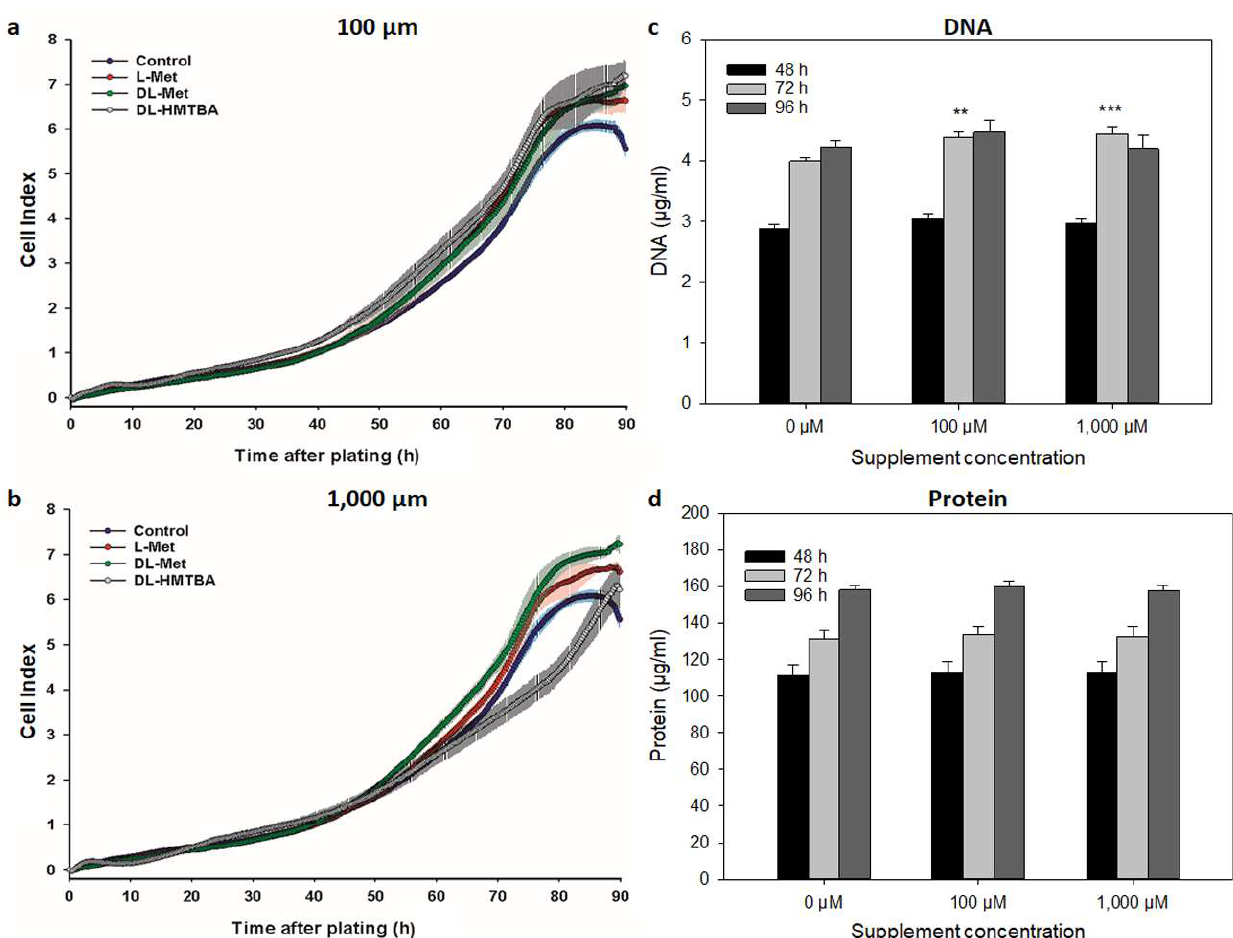
Figure 4. Effects of L-Met, DL-Met, and DL-HMTBA on growth kinetics ( a , b ) and DNA ( c ) and protein concentrations ( d ) of QM7 cells. Representative kinetic growth curves for QM7 cells (10,000 cells/well) supplemented with 100 µ M ( a ) or 1000 µ M ( b ) of L Met, DL-Met, or DL-HMTBA are shown in comparison with controls without supplement. For the evaluation of DNA ( c ) and protein ( d ) values, data for all methionine supplements were pooled since there were no statistical differences between them. Supplementation with methionine sources stimulated cell growth at both tested concentrations. DNA concentration in QM7 cells was significantly increased after methionine supplementation for 72 h. ** p ≤ 0.01 and *** p ≤ 0.001 vs. control; N = 3 (for growth curves) and N = 15 (for DNA and protein).